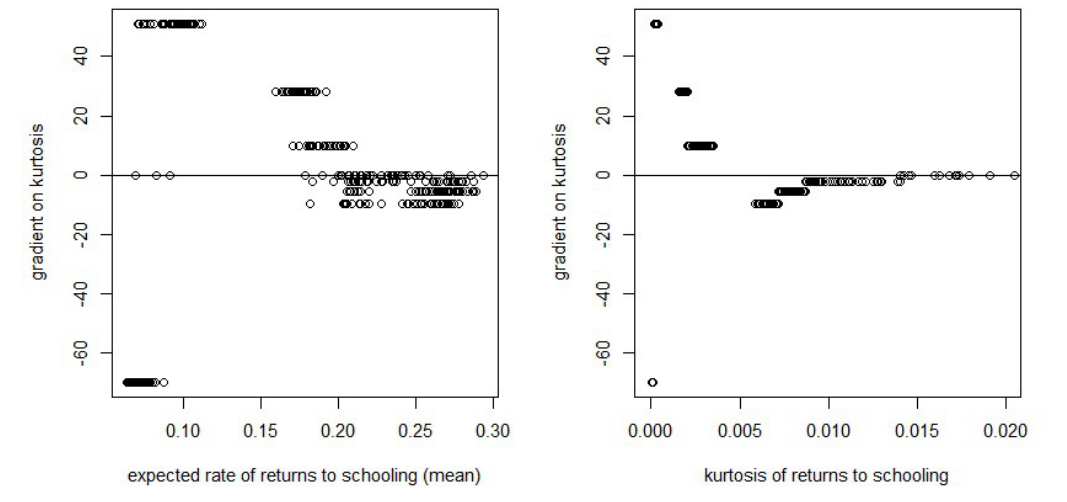
Figure 13. Spline gradients on kurtosis from Step 4: Stat. Sign.